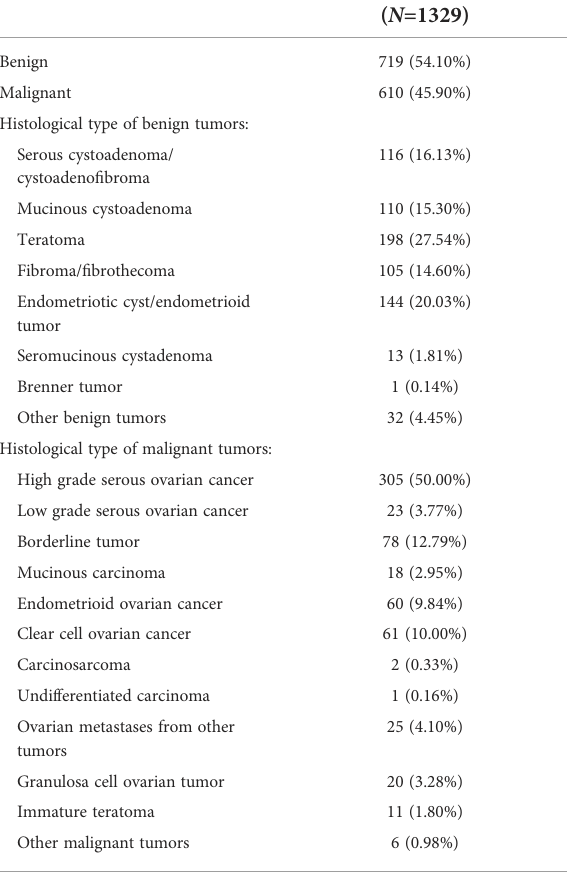
TABLE 1 Histopathological characteristics of ovarian tumors included in the study.